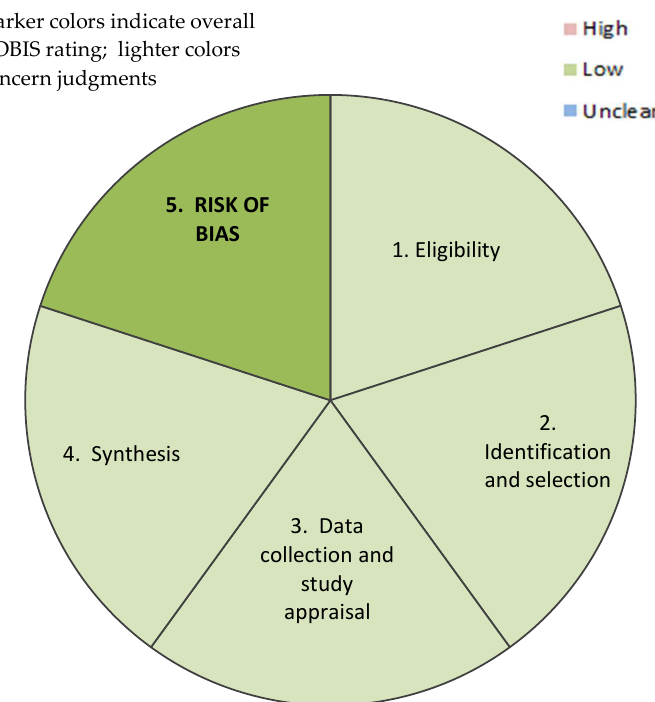
Figure A1. Graphical presentation of ROBIS evaluation results from this